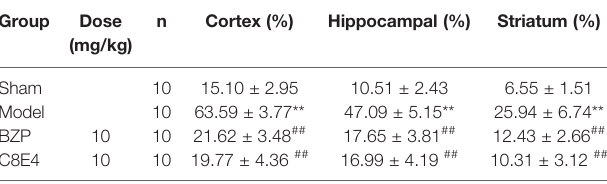
TABLE 3 | Effect of BZP on the expression of 15-LOX-2 in Cortex, Hippocampal and Striatum in MCAO rats. Group Dose n Cortex (%) (mg/kg)